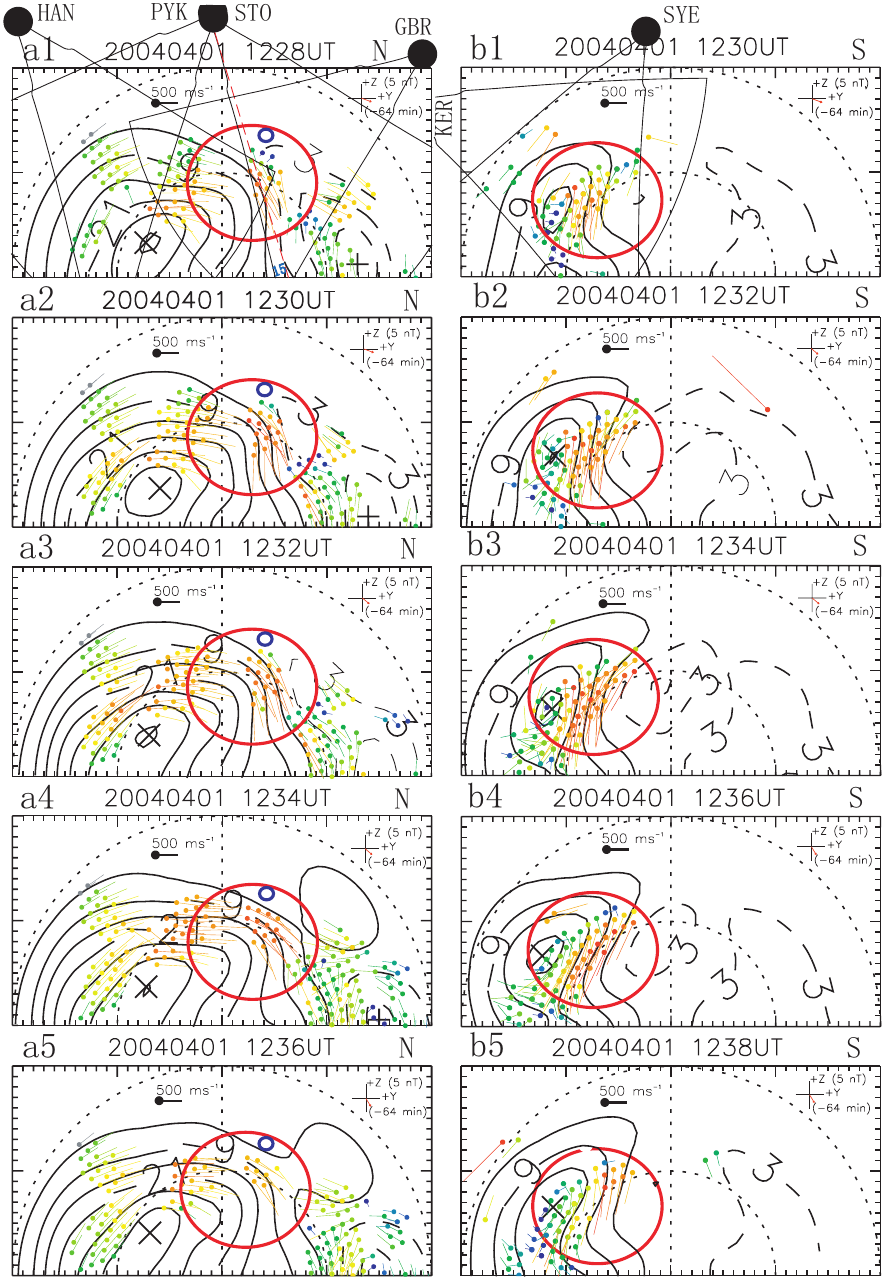
Fig. 4. Streamlines and vectors of the ionospheric flows derived from the northern (a1–5, c1–6) and southern (b1–5, d1–6) hemispheric SuperDARN velocity measurements shown on geomagnetic grids, obtained from the “map potential” algorithm. Maps are shown from 12:28 to 12:36UT and 12:46 to 12:56UT for the Northern Hemisphere and from 12:30 to 12:38UT and 12:52 to 13:02UT for the Southern Hemisphere. The field-of-view of the CUTLASS radars (HAN and PYK), Stokkseyri radar (STO), Goose Bay radar (GBR) and the Syowa East radar (SYE), Kerguelen radar (KER) are presented as fans in Fig. 4a1 and b1, respectively. The direction and magnitude of the lagged IMF are indicated at the right-hand upper corner of each map. The small blue circle is the footprint of the Cluster